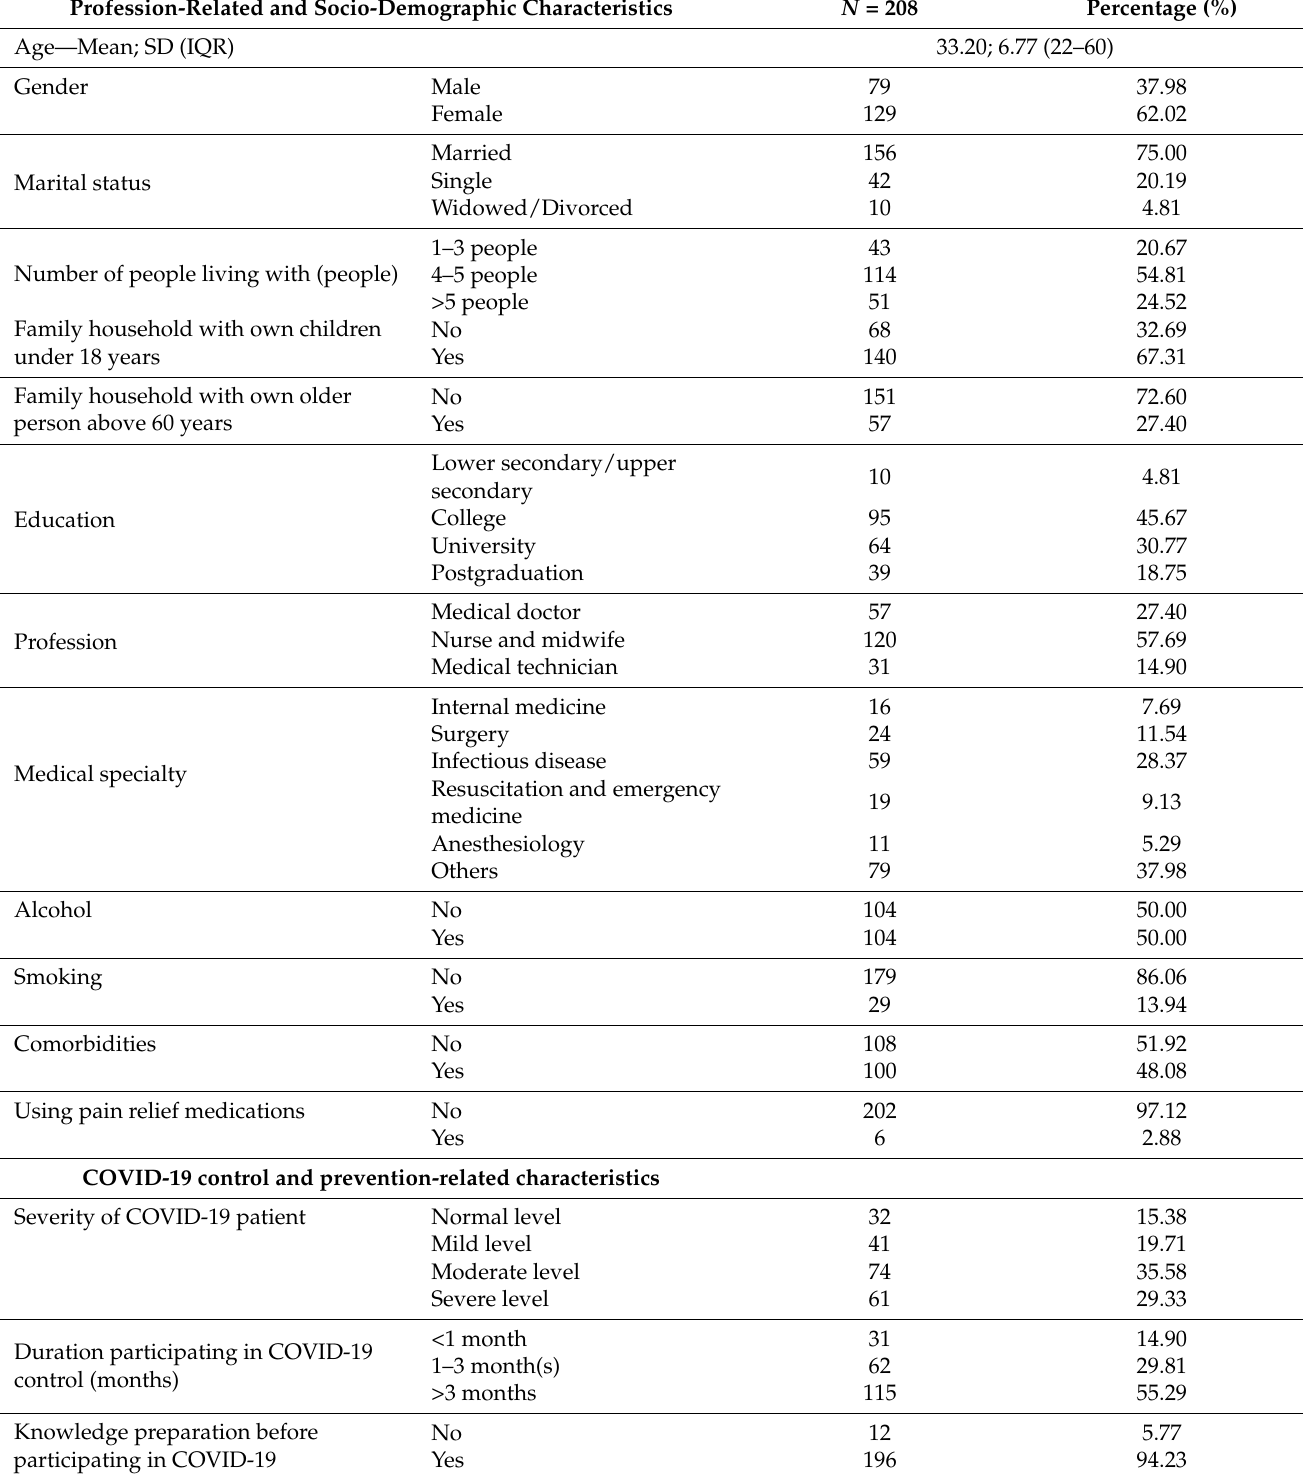
Table 2. Profession-related and socio-demographic characteristics of hospital health